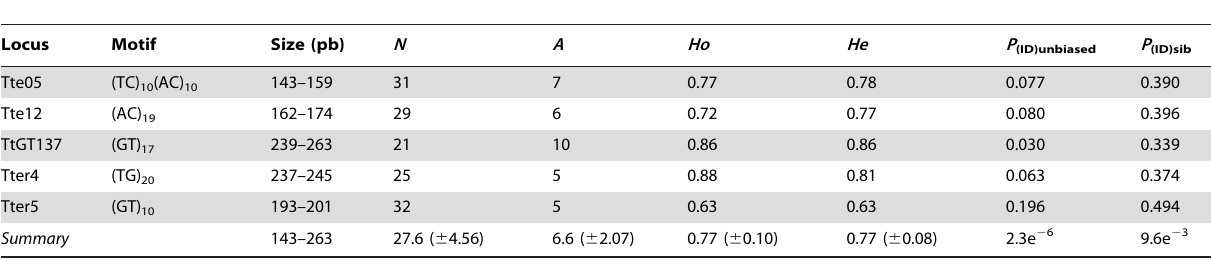
Table 1. Microsatellites loci used for genotyping individuals of T. terrestris .